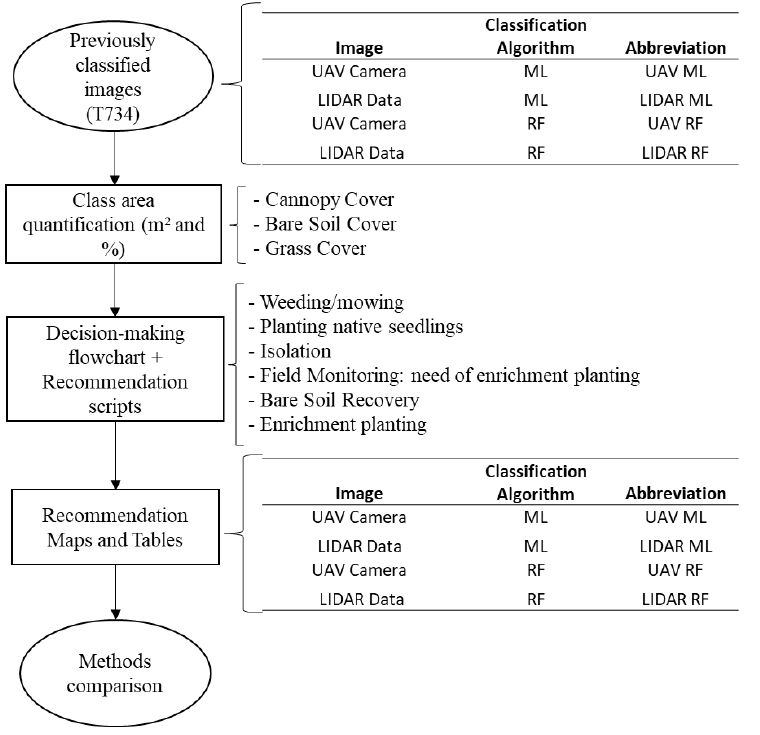
Figure 2. Flowchart representing the methodology used to generate recommendations from different classified images. UAV: Unmanned Aerial Vehicle, LiDAR: Light Detection and Ranging, ML: Maximum Likelihood, RF: Random Forest.